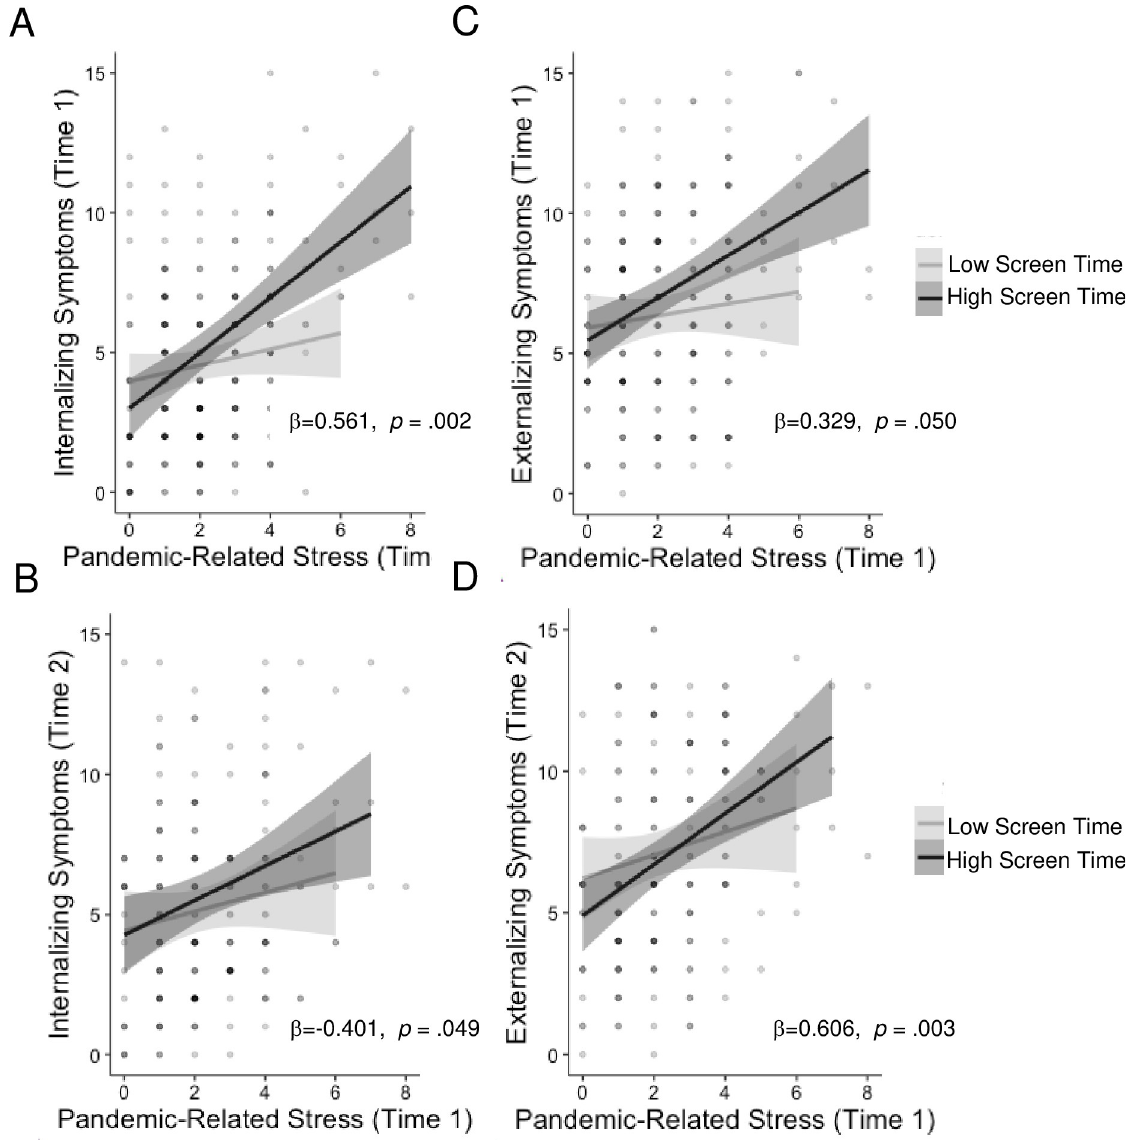
Fig 3. Passive screen time x stress interaction. Low screen time use buffers against pandemic-related increases in internalizing and externalizing psychopathology. All analyses control for age, sex, income-to-needs ratio, and pre-pandemic psychopathology symptoms.